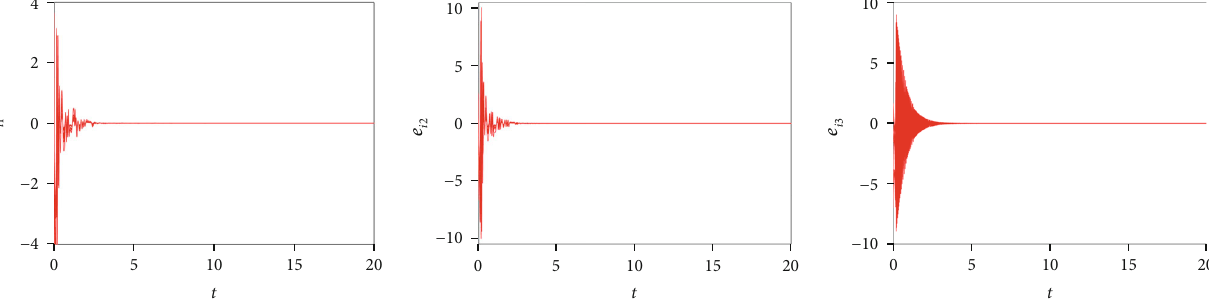
Figure 8: Synchronization errors e